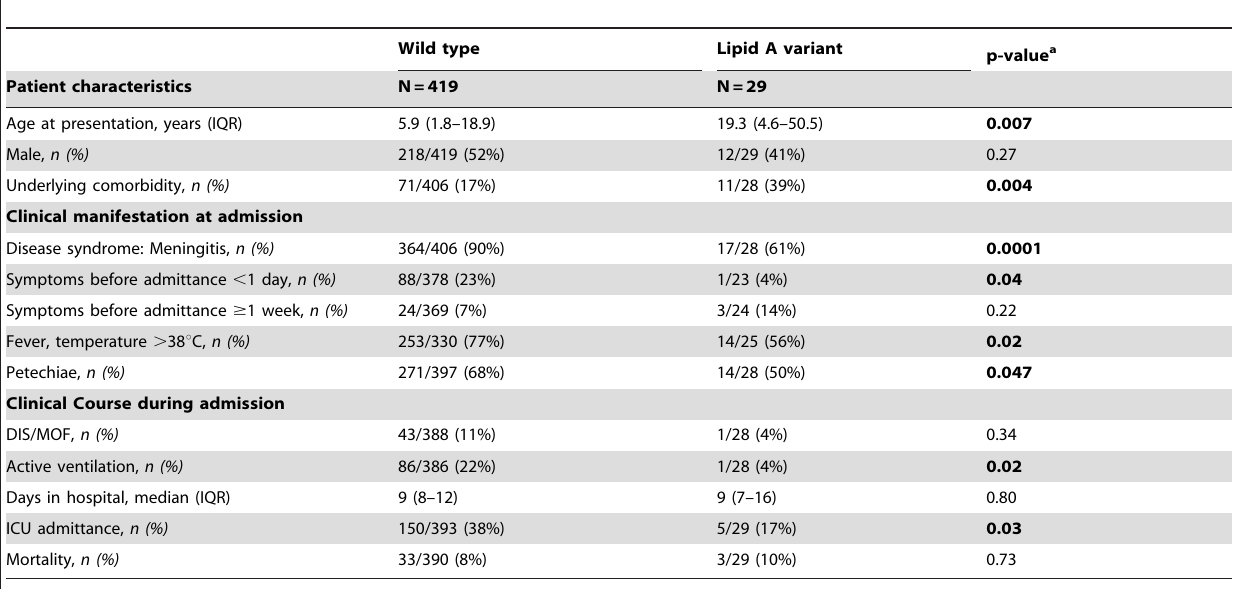
Table 3. Clinical manifestation on admittance and disease course in patients with meningococcal disease due to wild type or lipid A variant